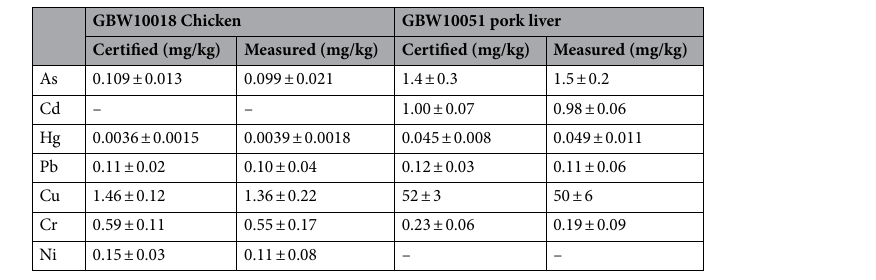
Table 1. Determination of certified reference materials ( n =